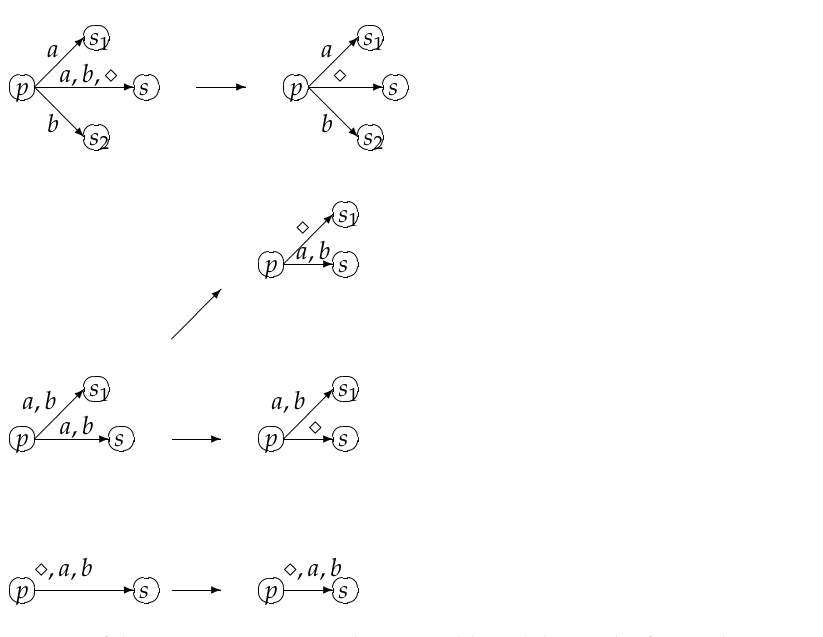
Figure 1. If the two states are strongly compatible and the result of strongly merging them is state p , the second (cid:5) transition will be from p to s and it may overlap with an a or a b transition, or a diamond transition. In this case, we keep just one (cid:5) transition and we drop the transitions on all letters b ∈ Σ from p to s that are overlapping with it, to avoid nondeterminism. In all cases any non-deterministic choice can be avoided by “absorbing” a letter transition into the “do not-care” symbol